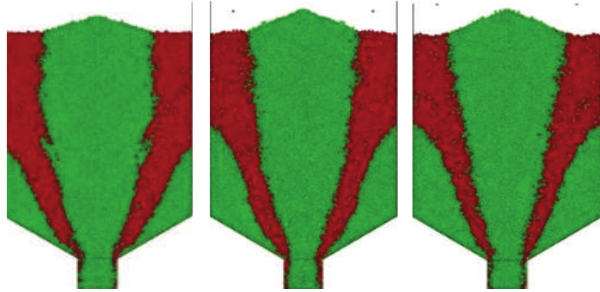
Figure 15: The result of the DEM simulation of the stagnant zone